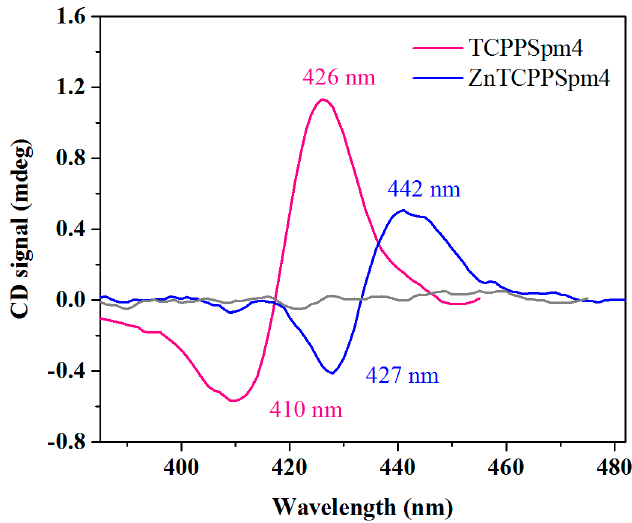
Figure 8. iCD signature of TCPPSpm4-Tel22 and ZnTCPPSpm4-Tel22 complexes prepared at stoichiometric amounts of porphyrins and DNA (4:1 for TCPPSpm4 and 12:1 for ZnTCPPSpm4). The data were scaled to 1 µM porphyrin. The CD scan of porphyrin alone is shown in grey. The data were smoothed using Savitzky–Golay smoothing filter with a 13-point quadratic function.